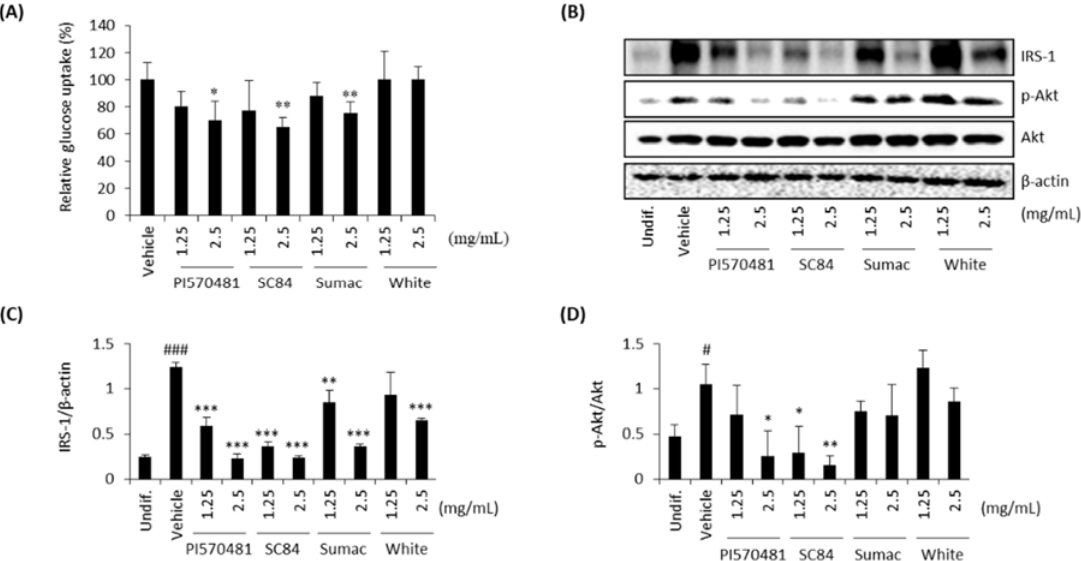
Figure 7. Sorghum bran extracts repressed glucose uptake and insulin signaling in differentiated 3T3 ‐ L1 cells. ( A ) 3T3 ‐ L1 cells were treated with 0, 1.25, and 2.5 mg/mL sorghum extracts (PI570481, SC84, Sumac, white) for 10 days. Glucose uptake was measured using 2 ‐ NBDG ( n = 4). ( B ) Western blot was performed for IRS ‐ 1 and phospho and total Akt ( B – D ). Values are means ± SD ( n = 3). Significance is indicated as # and *. # p < 0.05, ### p < 0.001 as compared to control (undifferentiated cells). * p < 0.05, ** p < 0.01, *** p < 0.001 as compared to untreated (0 mg/mL) differentiated cells.